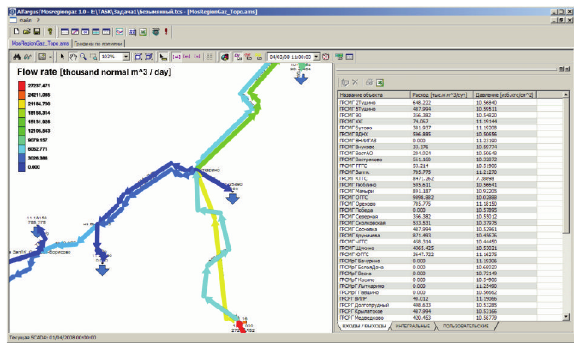
Figure 5: Example of flow diagram in the South-East MRG sector (cid:6) temporal section (cid:7)